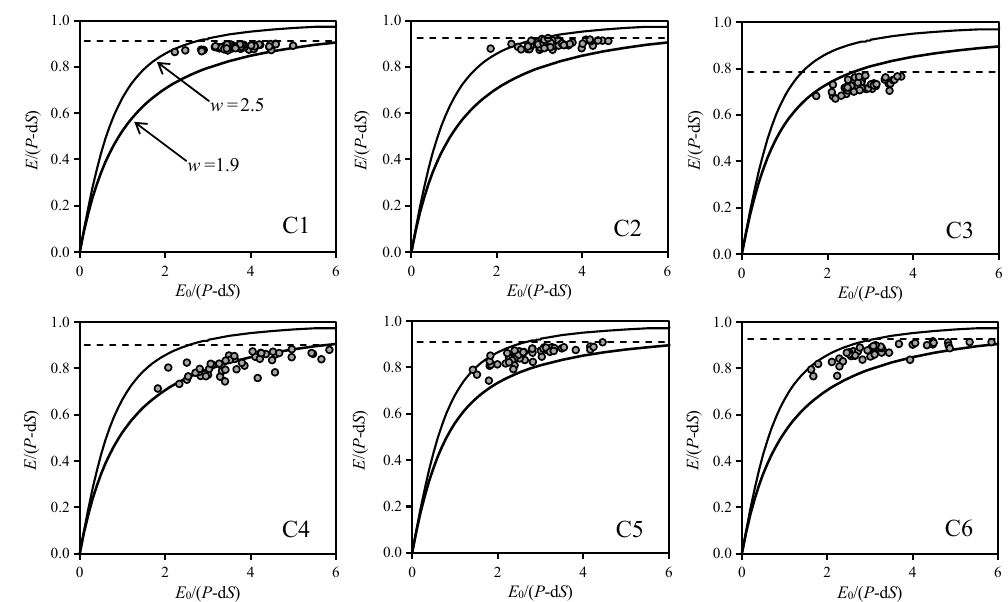
Figure 10. The annual water balance data in the modified Budyko space with the effective precipitation defined by Wang (2012). Dots are the data obtained for the catchments using the “natural” models. The solid curves represent the standard Budyko curves determined with Eq. (3) using E 0 /(P − (cid:49)S ) and E/(P − (cid:49)S ), respectively, instead of F and ϕ . Budyko curves of w = 1.9 and w = 2.5 are selected to bound the data points of catchment C1 and applied for the comparison with the other catchments. The dashed lines approximately represent the limitations of the E/(P − (cid:49)S )